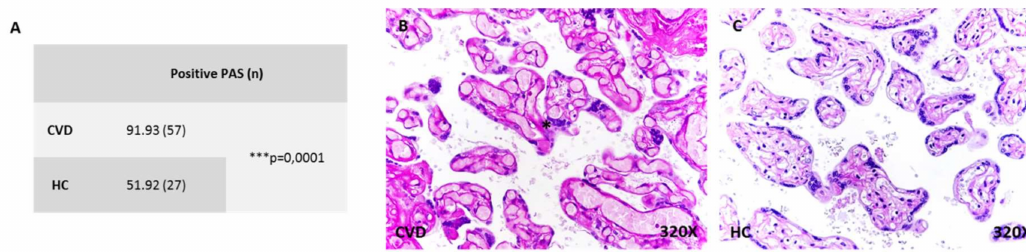
Figure 3. A. Percentage of positive periodic acid of Schi ff (PAS) placental villi in CVD and HC. B–C. Representative images of PAS in CVD ( B ) and HC ( C ). CVD = pregnancy-associated lower extremity chronic venous disease. HC = healthy controls with no history of CVD. p < 0.001 (***). Asterisk = positive